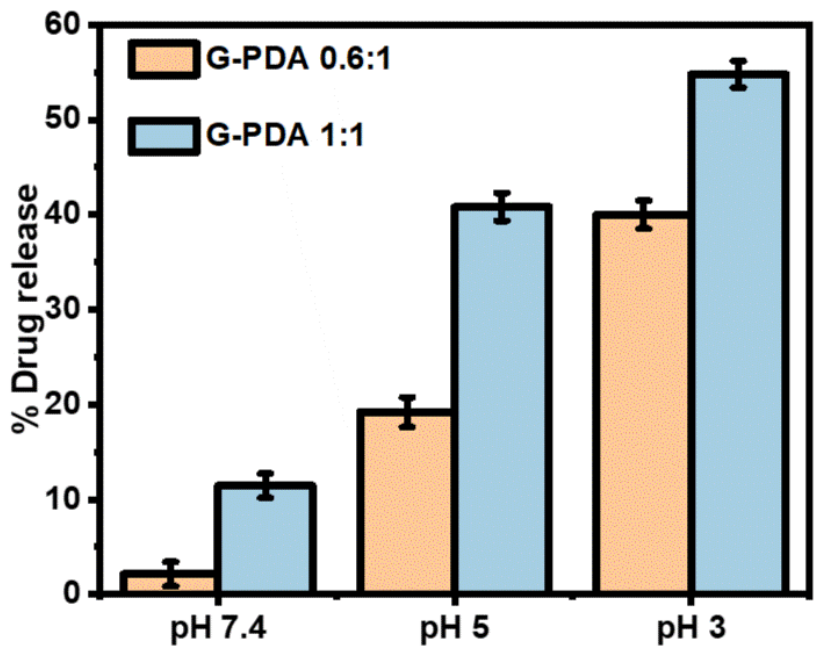
Figure 3. Comparison between % drug release from G-PDA 0.6:1 and G-PDA 1:1 at various pH